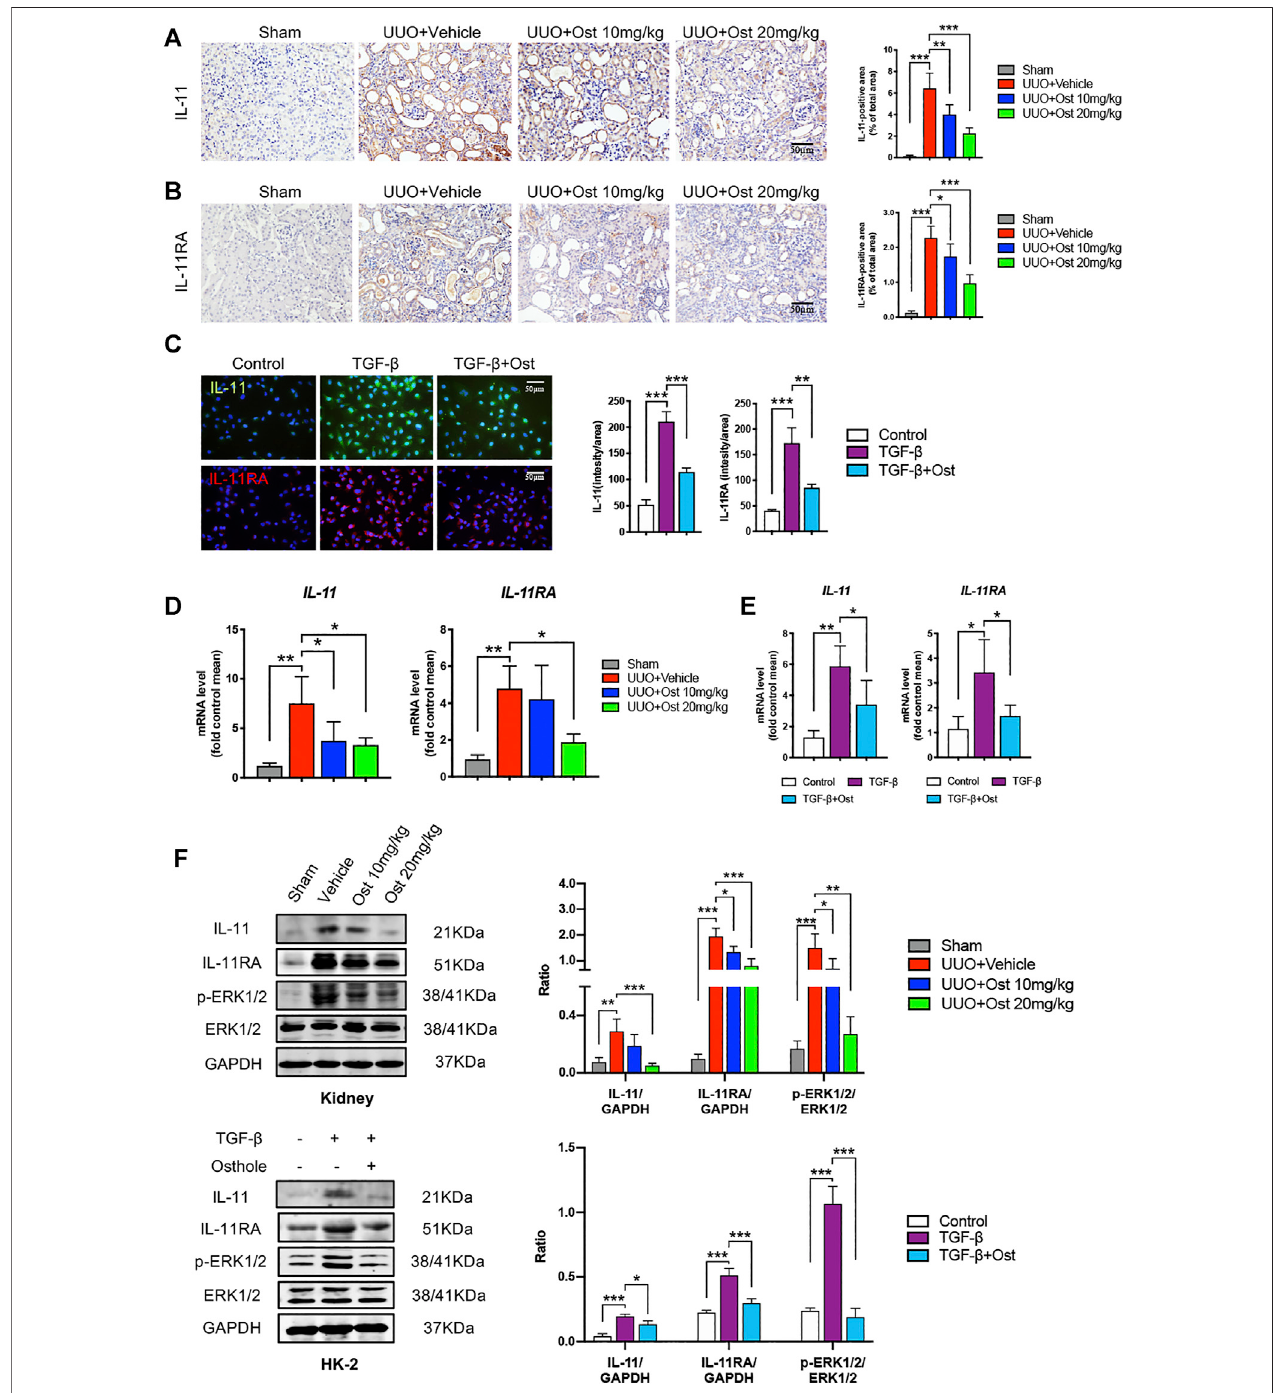
FIGURE 3 | Osthole inhibits IL-11/ERK1/2 signaling pathway in experimental renal fi brosis model in vivo and in vitro. (A) Representative immunohistochemistry stainingforIL-11;thequanti fi cation ofIL-11immunohistochemistrystaining.Scale bar,50 μ m.( n (cid:1) 6mice/group) (B) Representativeimmunohistochemistry stainingfor IL-11RA; the quanti fi cation of IL-11RA immunohistochemistry staining. Scale bar, 50 μ m. ( n (cid:1) 6 mice/group) (C) Representative immuno fl uorescence staining for IL-11 and IL-11RA;the quanti fi cation ofIL-11and IL-11RAimmuno fl uorescence staining. Scalebar, 50 μ m.( n (cid:1) 4repeats) (D) ThemRNA levels ofIL-11and IL-11RAin kidneyofdifferentgroups.( n (cid:1) 6mice/group) (E) ThemRNAlevelsofIL-11andIL-11RAinHK-2cellsofdifferentgroups.( n (cid:1) 4repeats) (F) Representativewesternblots forIL-11,IL-11RA, p -ERK1/2andERK1/2proteinexpressionsinkidneyandHK-2cells;thequanti fi cationofIL-11,IL-11RA, p -ERK1/2andERK1/2westernblots.( n (cid:1) 6 mice/group or 4 repeats in vitro ). All data are presented as means ± SD. * p < 0.05, ** p < 0.01, *** p < 0.001.